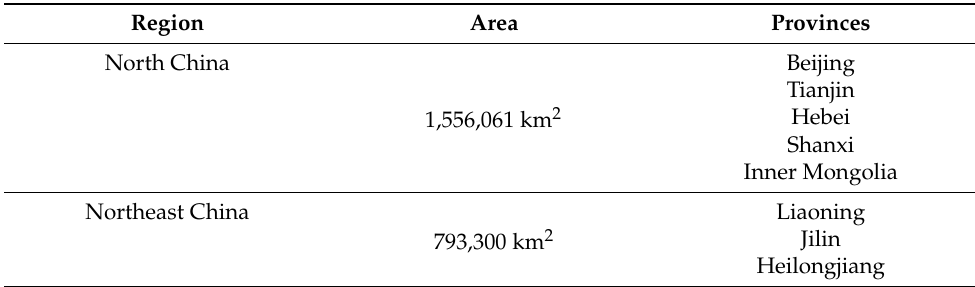
Table 1. Provinces/regions/municipal demography of